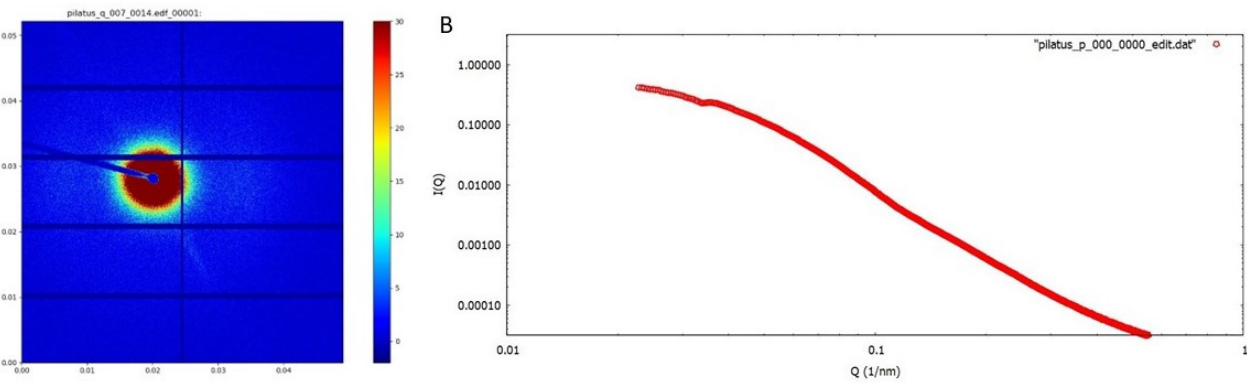
Figure 5. ( A ) The SAXS pattern for the empty mould cavity. The SAXS detector over the range in |Q| from 0.002 to 1.25 Å − 1 ( B ) The azimuthally averaged data shown in Figure